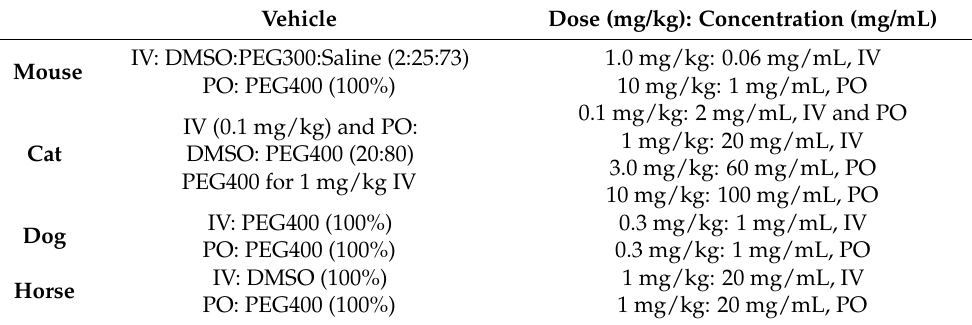
Table 4. Concentration and dosing volumes of dosing solutions.